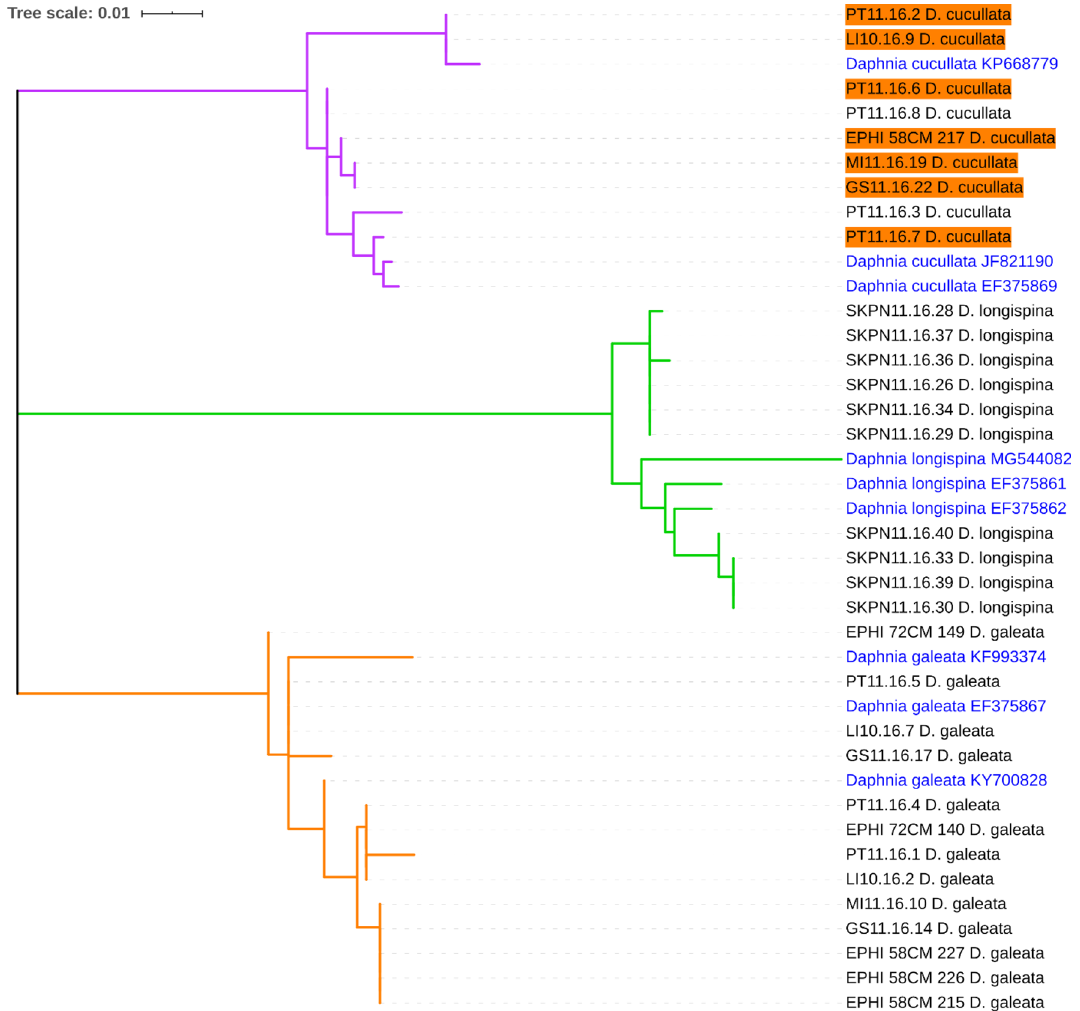
Figure 3. Maximum-likelihood phylogenetic tree computed with 1,000 bootstrap replicates, inferred from the alignment of partial COI gene sequences of 32 samples from the investigated lakes (black font) and 9 reference sequences downloaded from GenBank (blue font). Node colours indicate species assignment (inferred by reference sequences) and correspond to assignment by microsatellite data (Fig. 2). Orange boxes indicate samples assigned to D. galeata with microsatellites, but that clustered with D. cucullata by COI